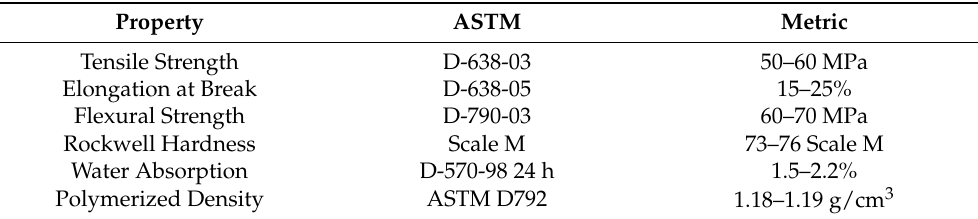
Table 3. Objet FullCure 720 properties [36].